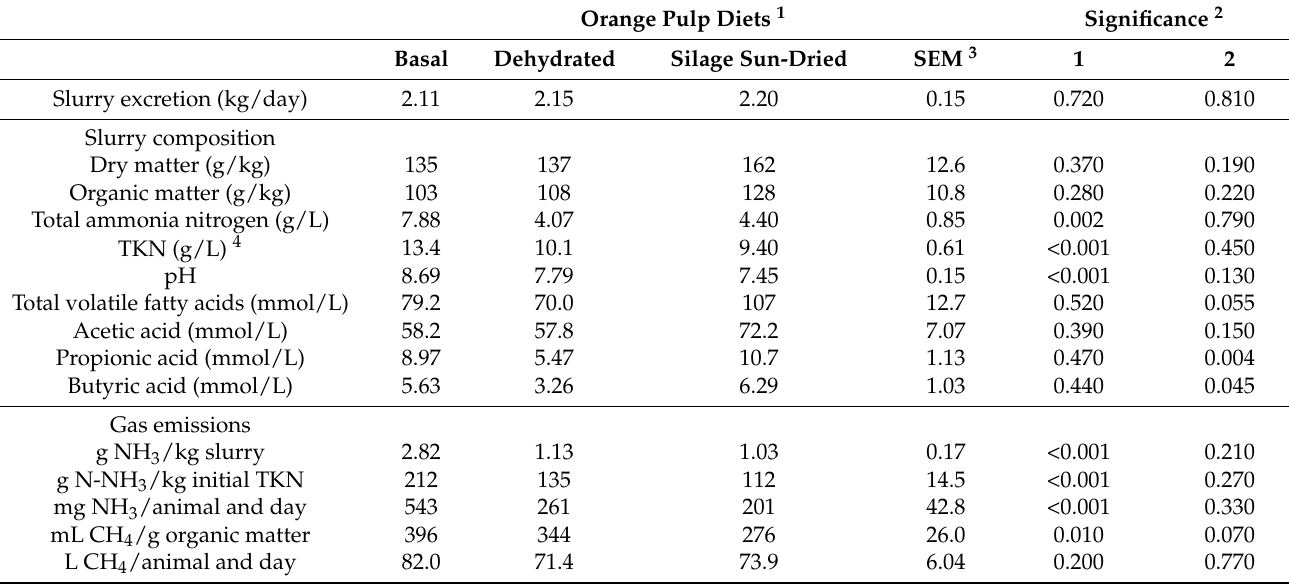
Table 7. Effect of experimental diets on reconstituted slurry excretion, composition and derived potential ammonia (NH 3 ) and methane (CH 4 )